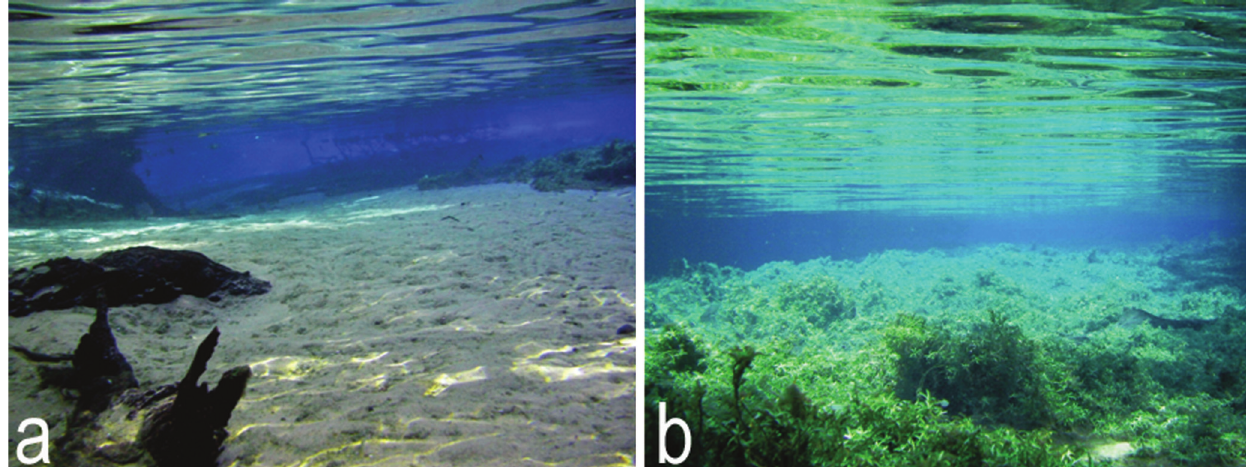
Fig. 2. General view of the altered ( a ) and unaltered ( b ) sites in the córrego Olho d’Água, Central-West Brazil. Photos: